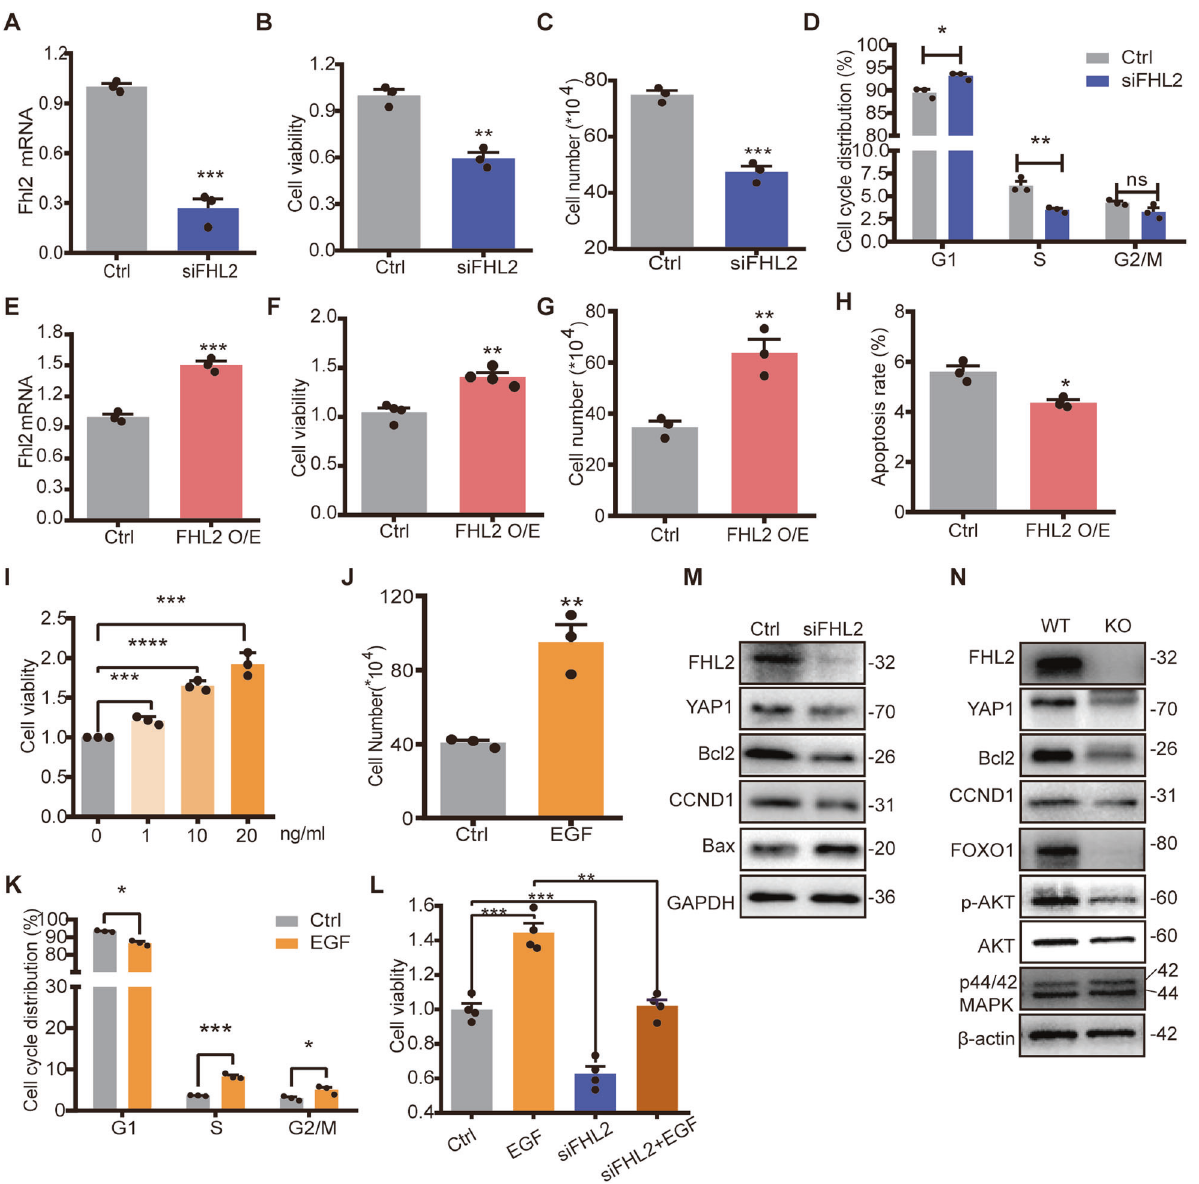
Fig. 3 FHL2 de fi ciency inhibited GC viability and EGF-induced GC proliferation in vitro. A Fhl2 mRNA levels in GCs transfected with scramble siRNA (Ctrl) or Fhl2 speci fi c siRNA (siFHL2). N = 3 for each group. β -actin was used as a loading control. B Knockdown of FHL2 inhibited cell viability signi fi cantly. Cell viability was detected by CCK-8. N = 3 for each group. C Quantitative data showing cell number changes in control and FHL2 knockdown cells. N = 3 for each group. D Flow cytometry showing cell cycle distribution in GCs transfected